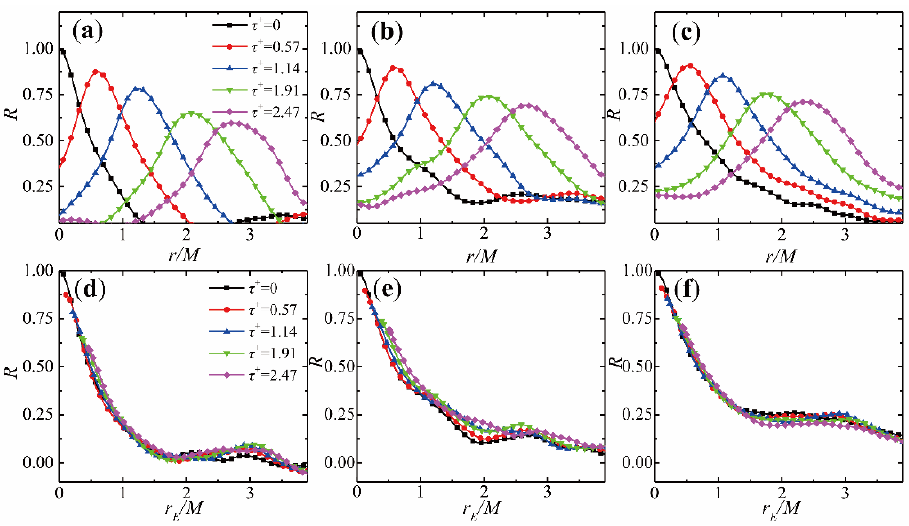
Figure 17. Space-time correlation curves at various vertical locations ( a ) z / M = 3.5; ( b ) z / M = 0.5; ( c ) z / M = − 3 and verification of the elliptic model at ( d ) z / M = 3.5; ( e ) z / M = 0.5; ( f ) z / M = − 3.